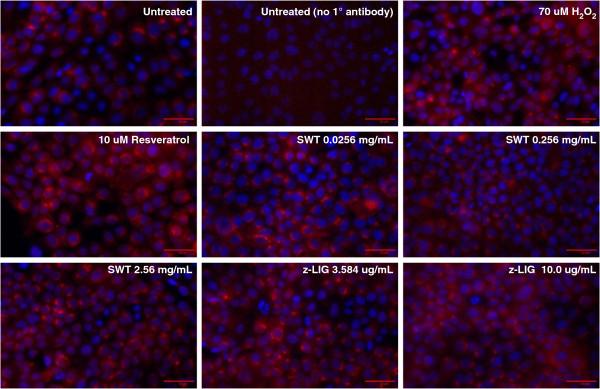
Increased nuclear translocation of Nrf2 by SWT or z-LIG. Immunocytochemistry of MCF-10A cells showed dose-dependent nuclear translocation of Nrf2 after treating with SWT or z-LIG for 24 hours. H2O2 (70 uM) and Resveratrol (10 uM) were used as positive controls. Cells were incubated with Nrf2 antibody (Alexa Fluor 594) after treatment and counterstained with Hoechst (5 uM) for nuclear staining, then visualized under a fluorescent microscope. All images were taken under 20X magnification. Images were merged using ImageJ software (National Institutes of Health). The experiment was repeated twice and obtained consistent results.